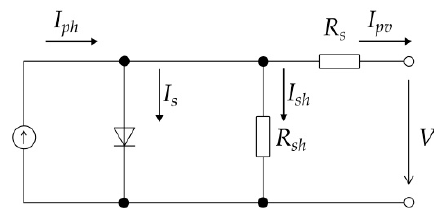
Figure 4. Equivalent schematic of one-diode model of photovoltaic (PV) panel acc. to [11].